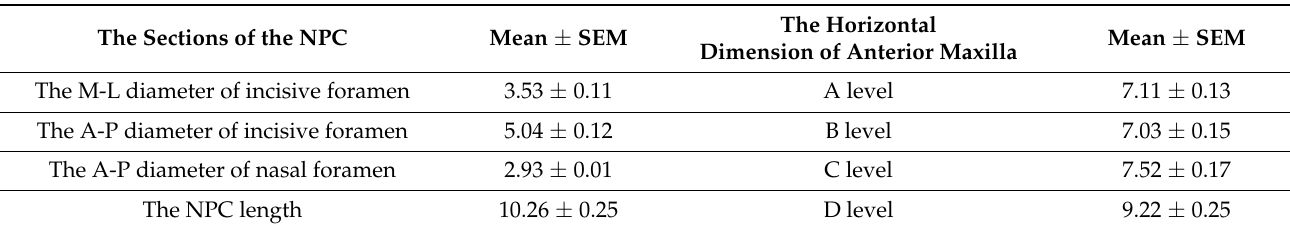
Table 1. The diameters at different sections of the nasopalatine canal and the horizontal dimension of the anterior maxilla